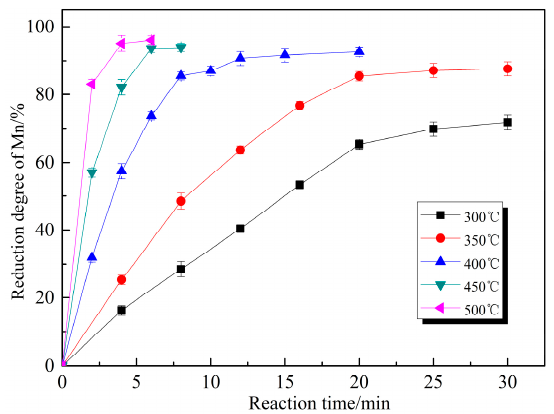
Figure 4. The effect of temperature on the reduction degree of MnO 2. Figure 4. The e ff ect of temperature on the reduction degree of MnO